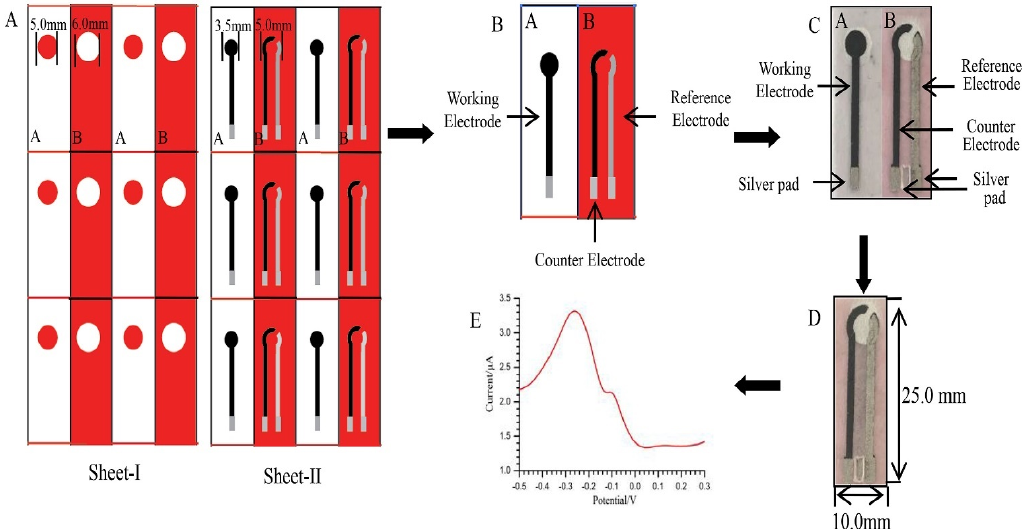
Figure 12. The fabrication of the paper-based electrodes by Fan et al. ( A ) Sheet I and II indicate the screen-printed wax patterns. Paper A and B of Sheet I contain the sample zone (5.00 mm) and the auxiliary zone (6.00 mm), which were designed for the carbon counter, working, and Ag / AgCl reference electrodes. Sheet II contains Paper A and B with patterns for the above three electrodes. ( B ) Represent a full screen-printed electrode system with all the three electrodes: counter, working, and reference. ( C ) A photograph of the produced electrode system with a silver pad. ( D ) Folded electrode. ( E ) A typical signal from the DPV used for the detection of the immunosensor. Reprinted with permission from [152], copyright 2019 Elsevier